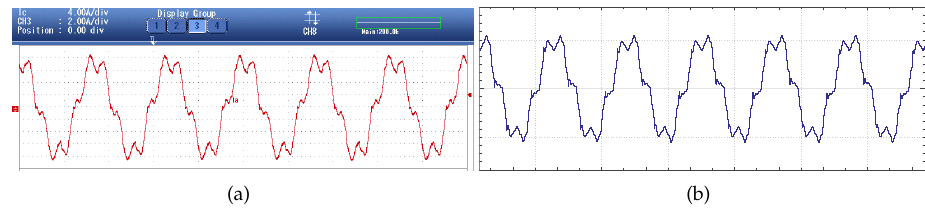
Figure 21. Grid current waveform for Case 7, THD = 21.5%: ( a ) measured current; ( b ) simulated current.